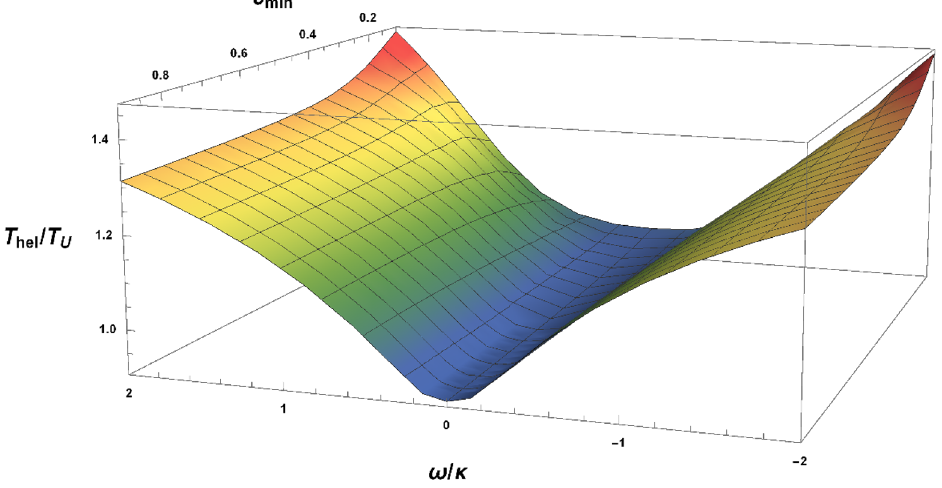
Figure 9 . The e(cid:11)ective temperature scaled to the Unruh temperature as a function of !=(cid:20) and the minimum velocity 0 : 1 (cid:20) (cid:29) min (cid:20) 0 : 9 in the case of hypertor motion with (cid:20) = b = 1. The coldest temperature T hel =T U (cid:25) 0 : 90 is registered by a detector moving with velocity (cid:29) = 0 : 9, in the limit !=(cid:20) !